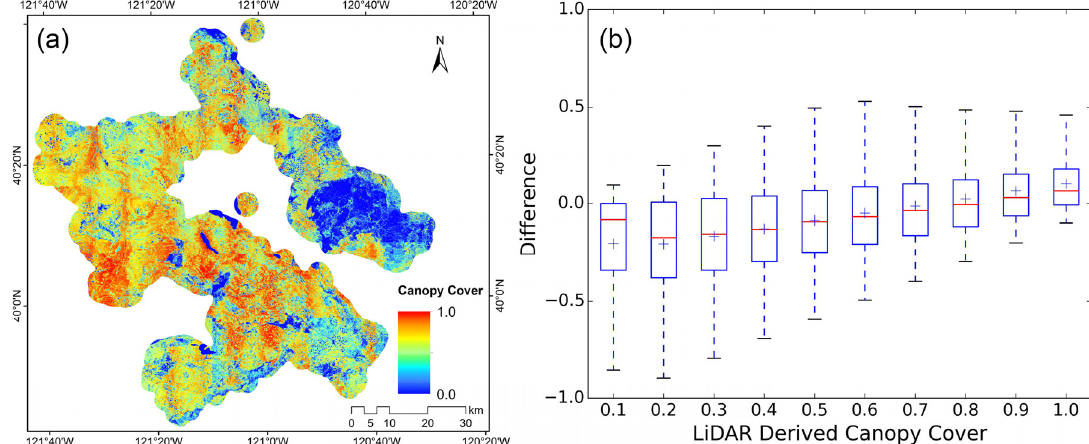
Figure 5. ( a ) Estimated canopy cover distribution from aerial imagery in the study area; ( b ) Boxplot of differences between the airborne LiDAR-derived canopy cover and the estimated canopy cover within the airborne LiDAR footprint (airborne LiDAR-derived canopy cover minus estimated canopy cover). The blue “+” indicates the mean difference of the corresponding group. Numbers 0.1–1.0 on x axis represent the airborne LiDAR-derived canopy cover group of 0–0.1, 0.1–0.2, 0.2–0.3, 0.3–0.4, 0.4–0.5, 0.5–0.6, 0.6–0.7, 0.7–0.8, 0.8–0.9, and 0.9–1.0,